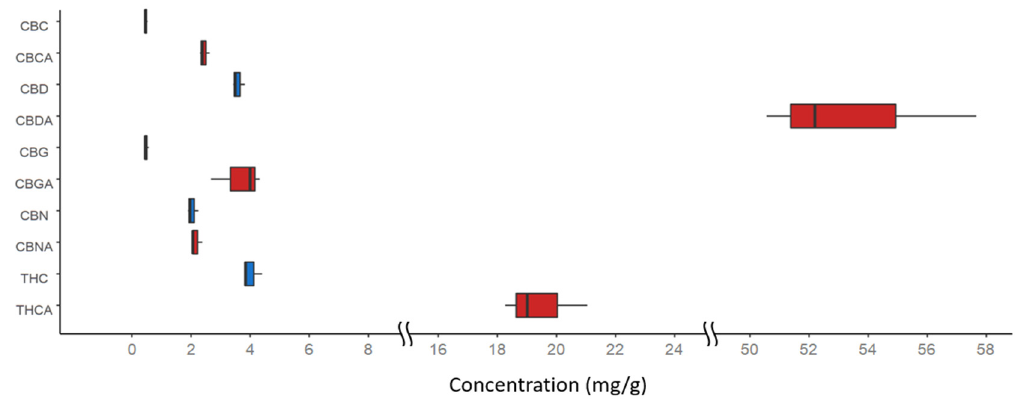
Figure 5. Boxplot representations of cannabinoid quantities per one gram of dry cannabis flower ( n = 3).